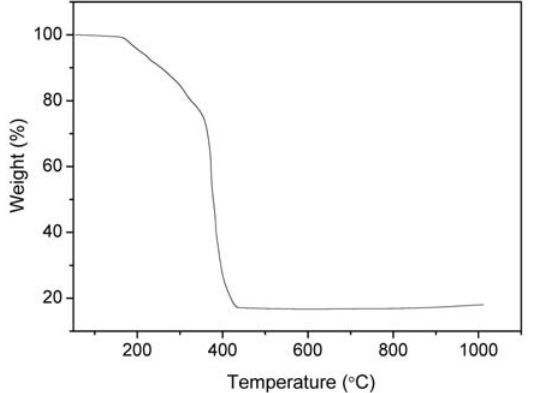
Figure 5. TG-DTA curves of the complex.